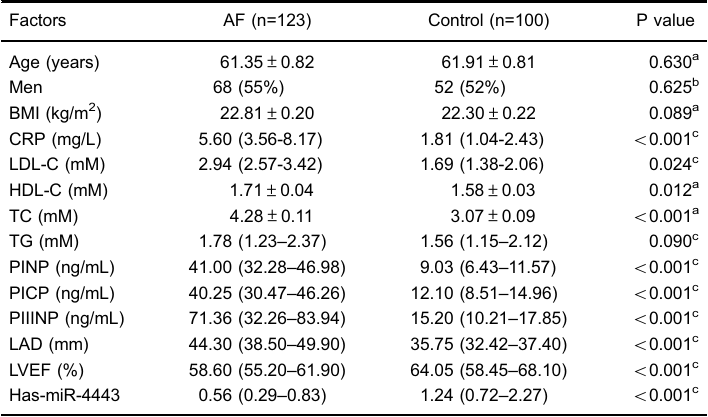
Table 1. Clinical data for atrial fi brillation (AF) patients and control group.